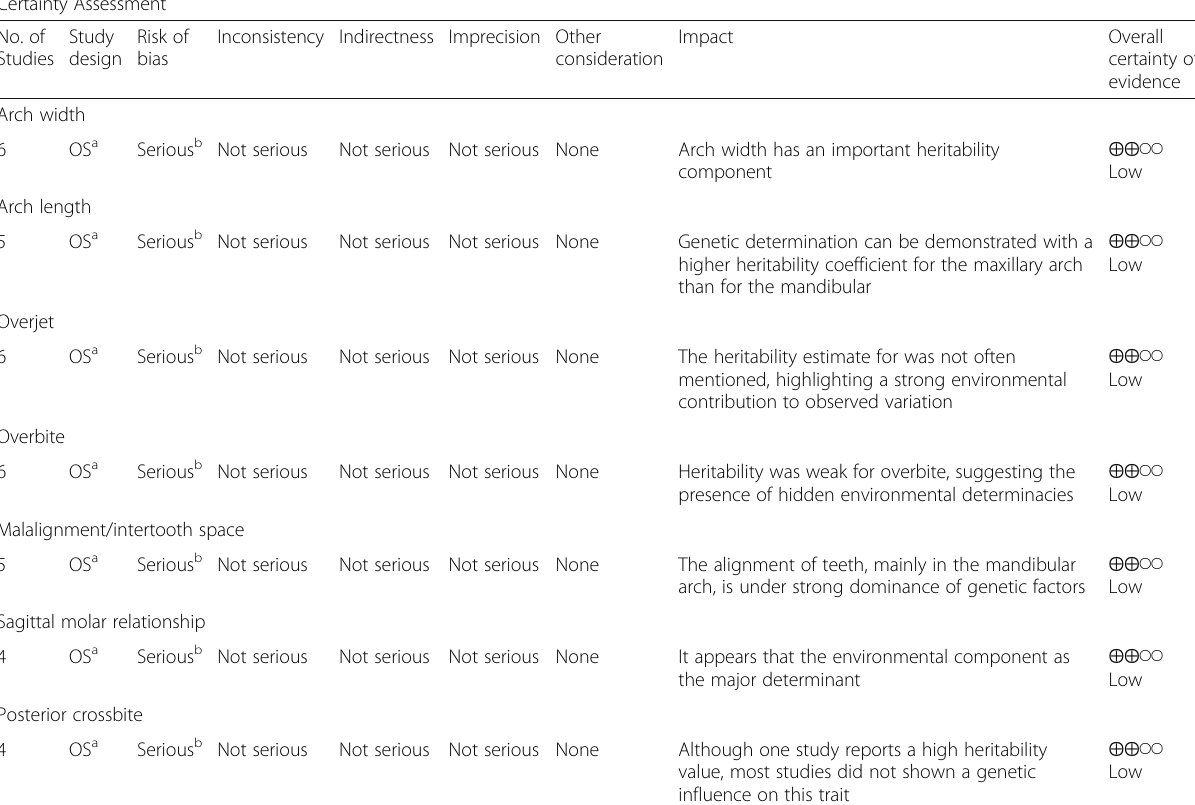
Table 3 GRADE evidence profile table about influence of heritability in main occlusal traits Certainty